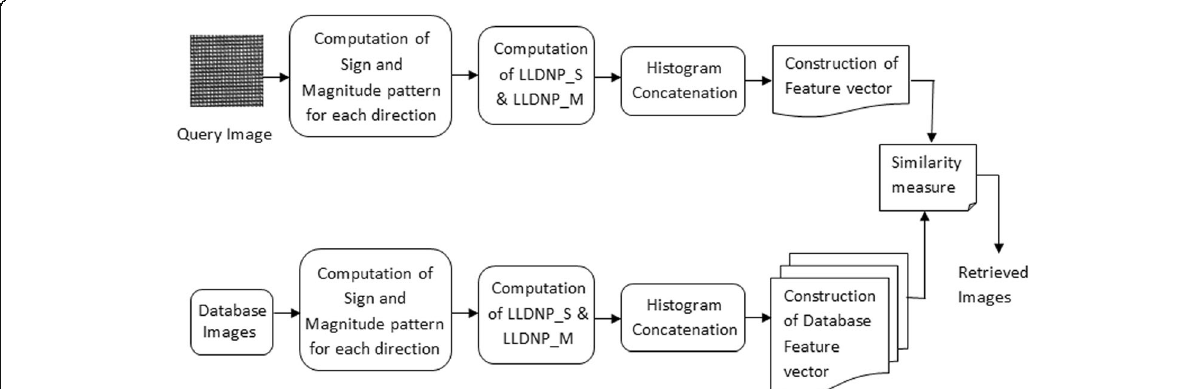
Fig. 3 Proposed system framework. For the given query image, the sign and magnitude patterns for each direction are computed. Finally, the LLDNP_S and LLDNP_M are computed for the entire image. The histogram is built for LLDNP_S and LLDNP_M patterns. The histogram is concatenated and the features are extracted. The similarity measure is used for classification and finally the relevant images are retrieved from the